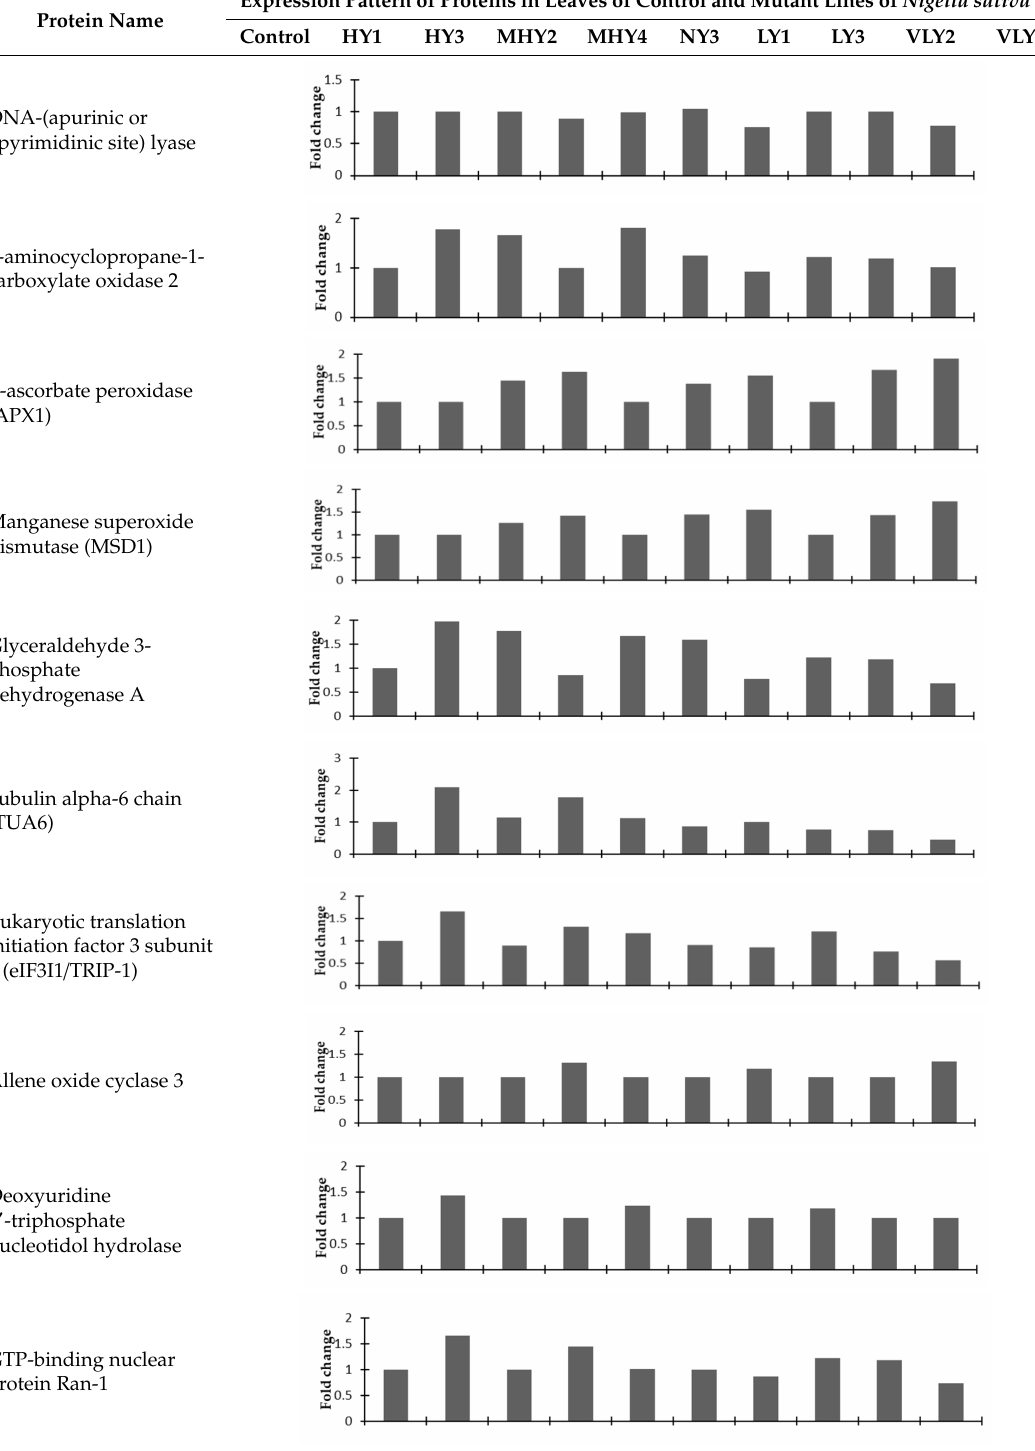
Expression Pattern of Proteins in Leaves of Control and Mutant Lines of Nigella sativa Protein Name